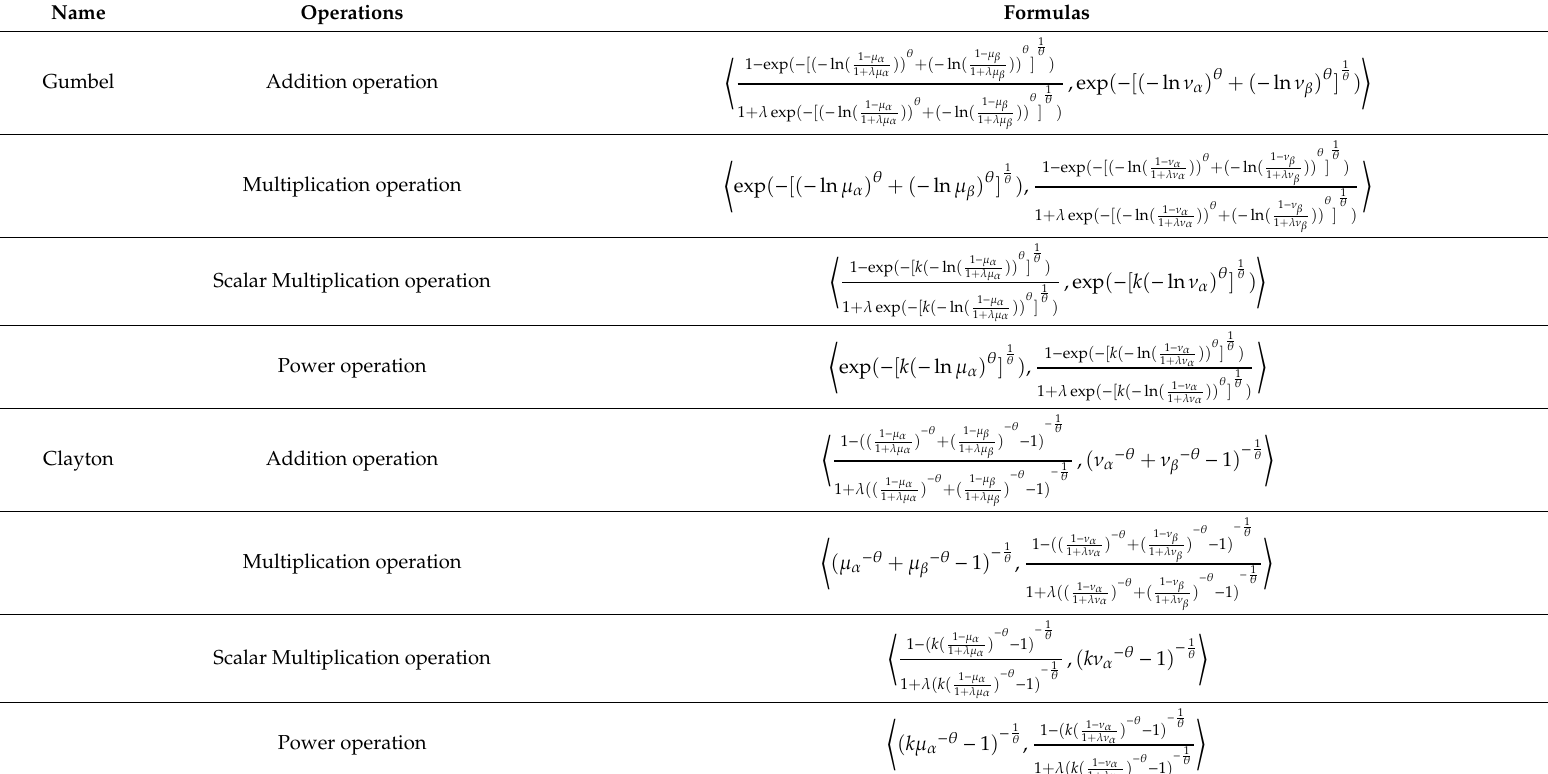
Table 3. Operations for intuitionistic fuzzy values (IFVs) via Sugeno Fuzzy